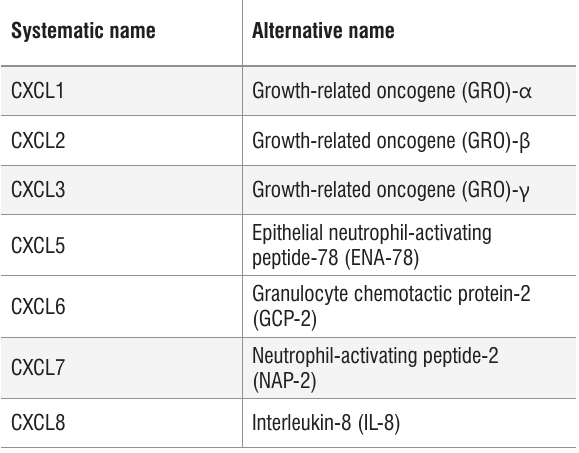
Table 4: Examples of neutrophil-targeted CXC/ELR +